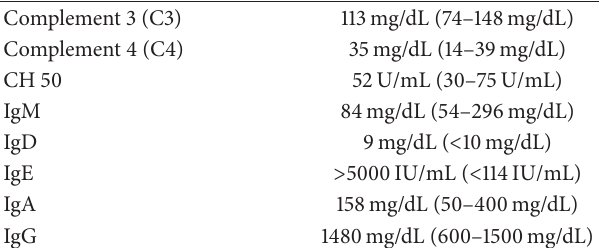
Table 2: Other laboratory work-ups.